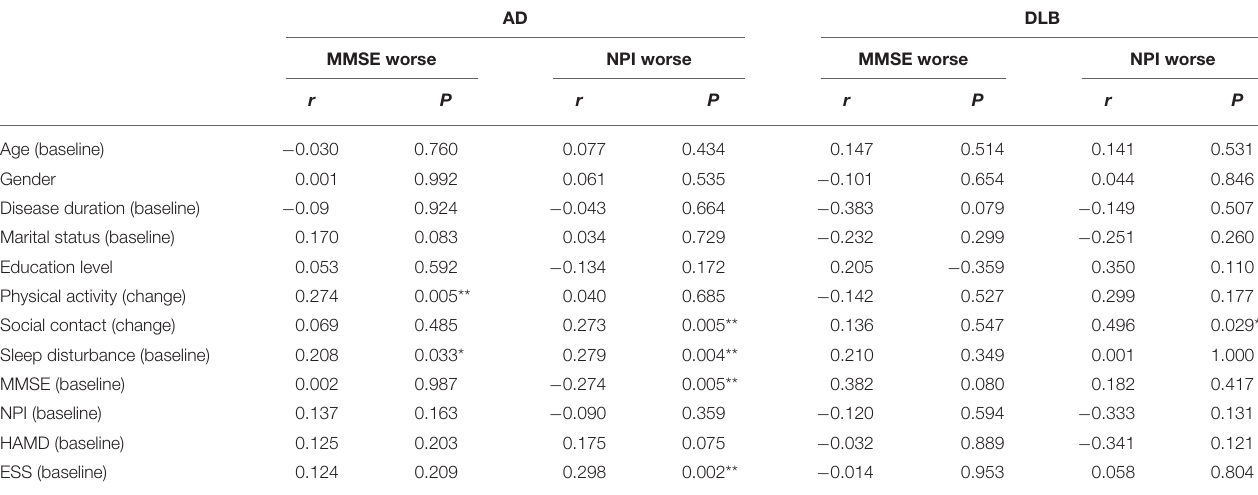
TABLE 3 | Correlation between cognitive and neuropsychiatric decline and hypothesized related factors in Alzheimer’s disease (AD) and probable dementia with Lewy bodies (DLB).